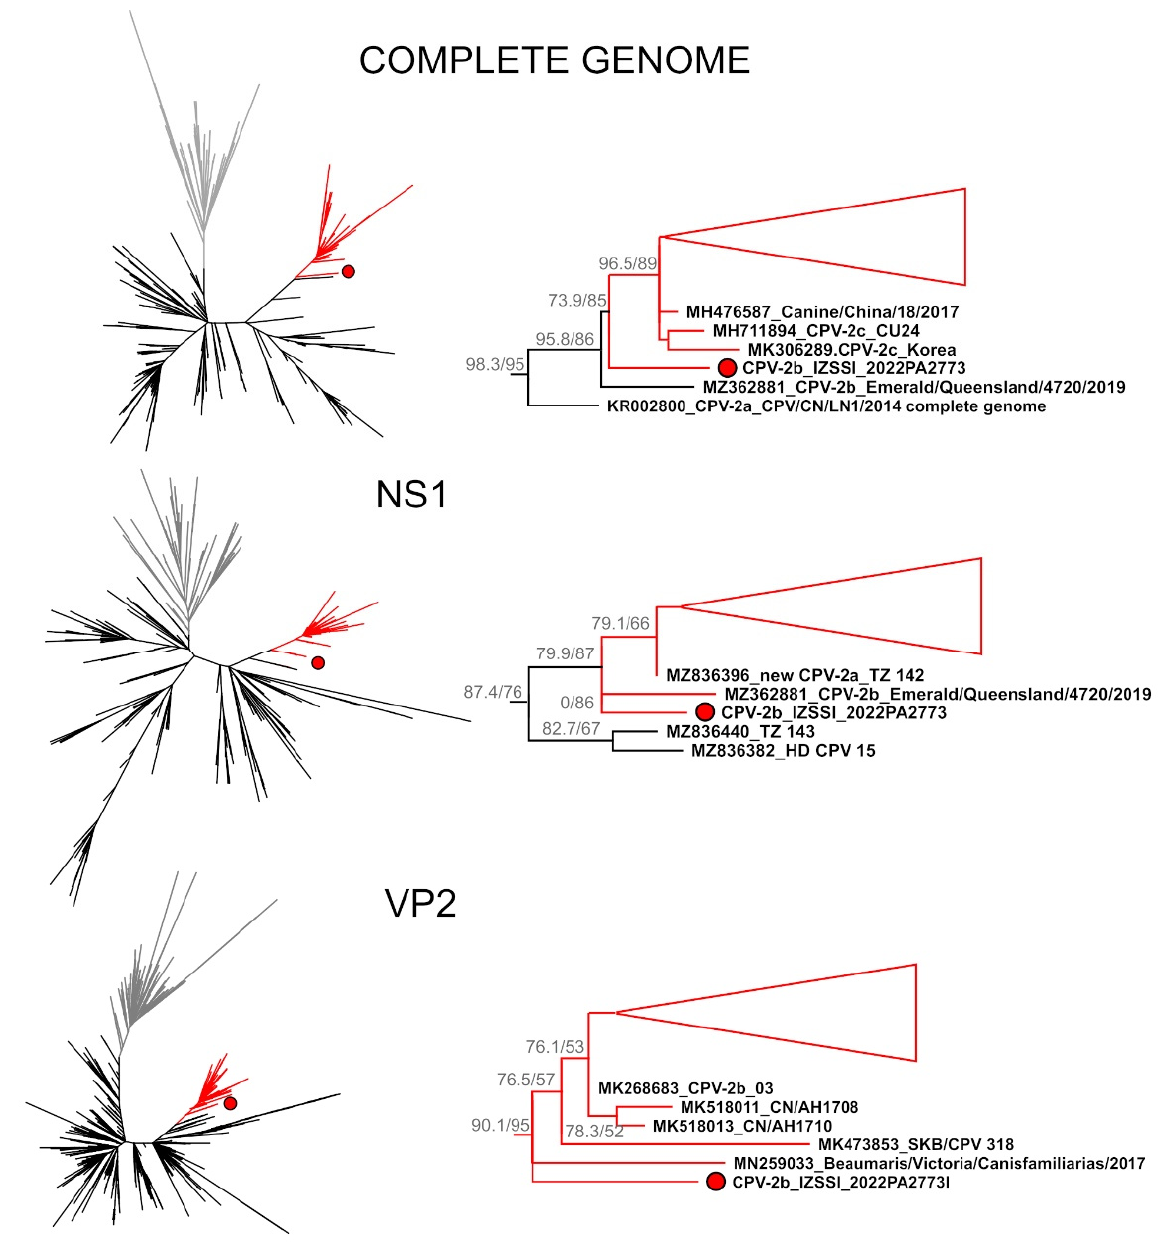
Figure 1. Phylogenetic analyses of the CPV-2b strain identified in this study. The phylogenetic trees compare the sequence obtained in this study, indicated by a red circle, with all CPV-2 and FPLV (used as outgroup and indicated by grey branches) sequences available in the GenBank. The full trees based on the complete genome ( top ), NS1 ( middle ) and VP2 ( bottom ) genes are shown on the left while enlargements of the clades, including the strain identified in this study (indicated by red branches and including Asian CPV-2c-like strains), are shown on the right. Triangles depict collapsed clades, which are shown in extenso in Supplementary Figure S1. Trees were built with the maximum-likelihood method with IQ-Tree, and the outcomes of the SH-aLRT and bootstrap test (1000 replicates) are shown for the main nodes. Sequences are labelled with their accession number followed by the strain names.